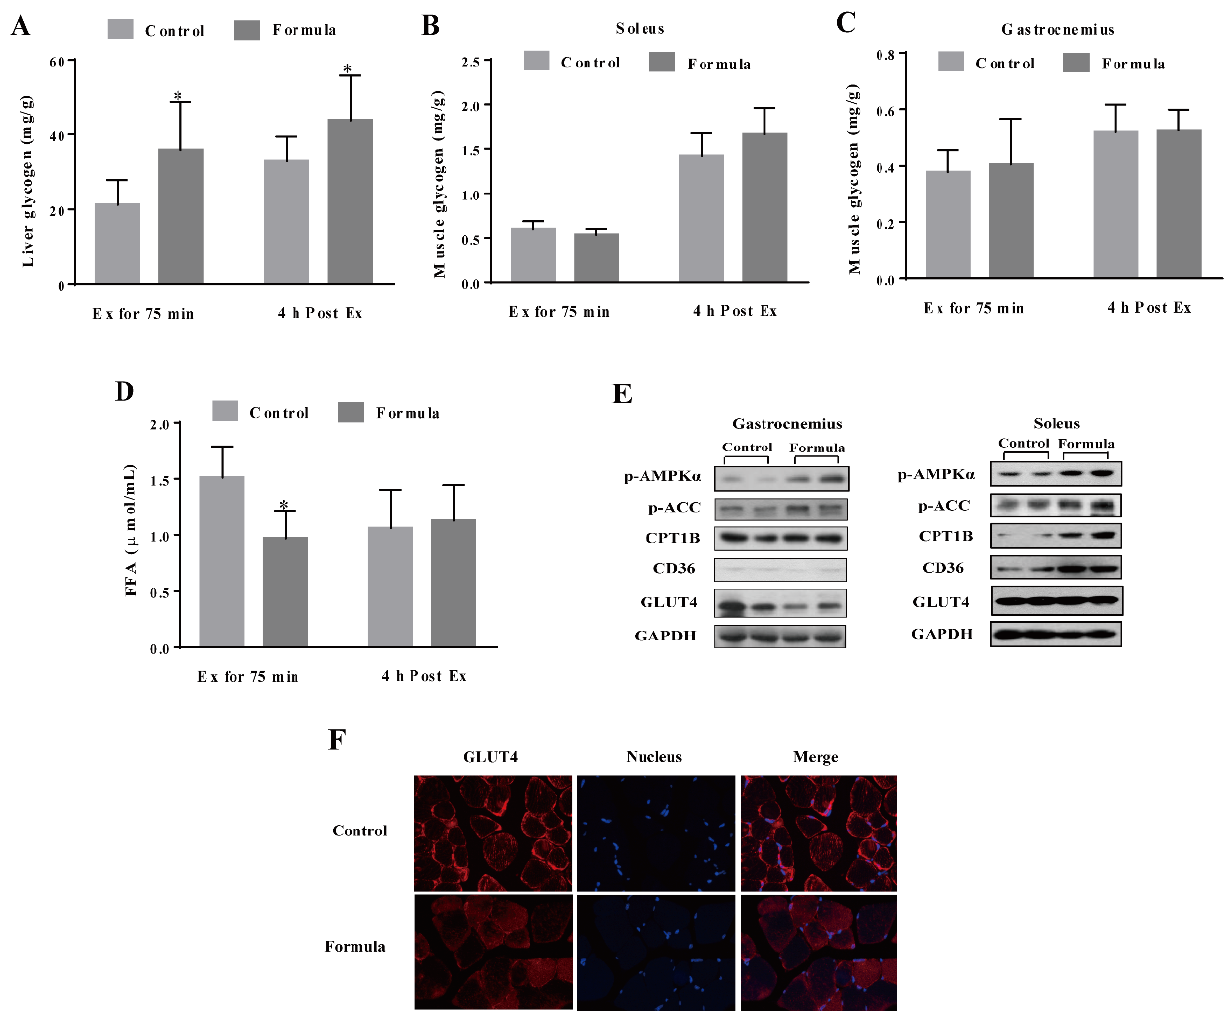
Figure 4. The level of energy substrates glycogen in the liver ( A ), soleus ( B ), and gastrocnemius ( C ) muscles and serum FFA ( D ) in each group after Ex for 75 min and 4 h post Ex for comparison among groups at the same time course. The protein expression in the glucose and fatty acid metabolism-related pathways in the gastrocnemius and soleus muscles in each group after Ex for 75 min ( E ). Immunofluorescence staining of the GLUT4 in the gastrocnemius muscles in each group after Ex for 75 min ( F ). Images were captured at the 400 × magnification. Scale bar = 50 µ m. The GLUT4 is shown in red, while the nucleus is depicted in blue. Ex: exercise. Ex for 75 min: Exercise for 75 min according to the protocol of the exhaustive treadmill test. 4 h post-Ex: 4 h after completion of the exercise for 75 min. FFA: free fatty acids; p-AMPK α : phospho-adenosine monophosphate-activated protein kinase α ; p-ACC: phospho-acetyl CoA carboxylase; CPT1B: carnitine palmitoyl-transferase 1B; CD36: fatty acid translocase; GLUT4: glucose transporter type 4; GAPDH: glyceraldehyde-3-phosphate dehydrogenase. The light gray column denotes the control group, while the deep gray column represents the formula group. The data are expressed as mean ± SD, N = 6, * p < 0.05, compared to the control group at the same time.